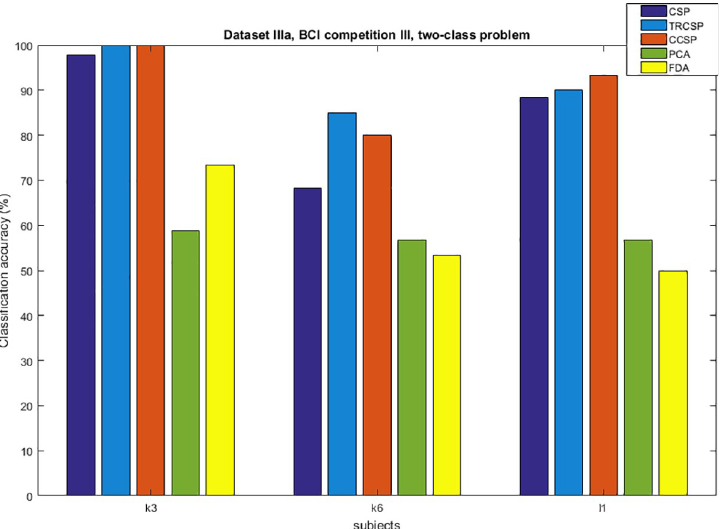
Fig 2. Comparison between classification accuracy of methods for two-class problem in dataset IIIa, BCI competition III.